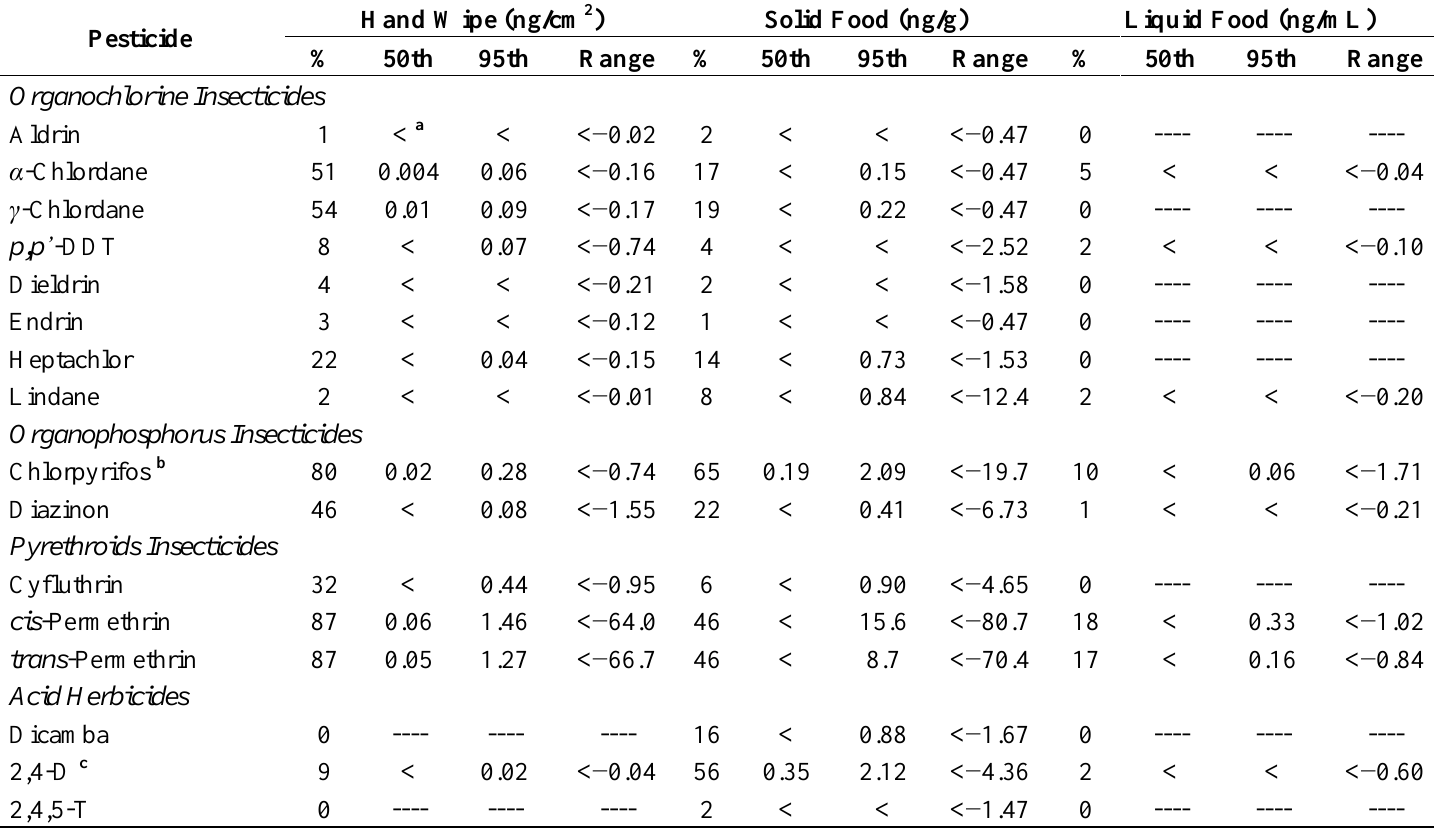
Table 5. Concentrations of pesticides in personal exposure samples collected from 129 children at their homes in North